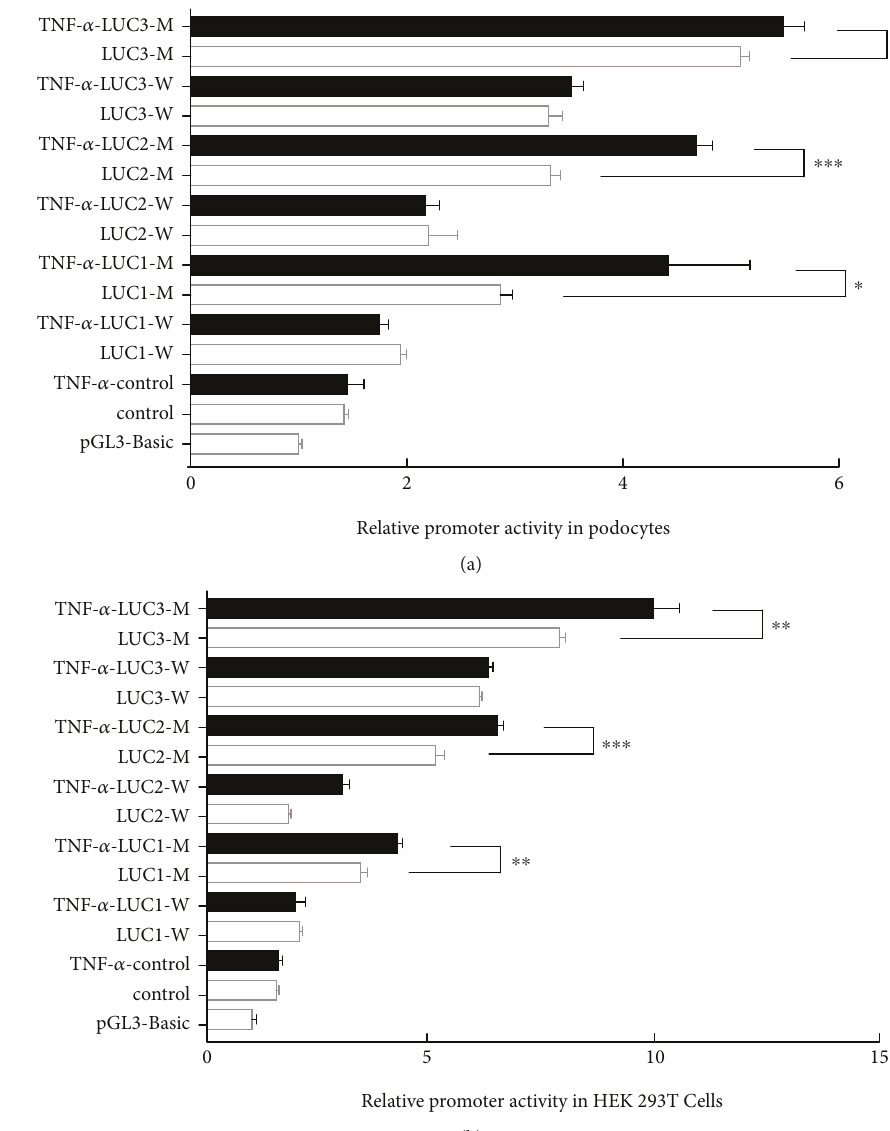
Figure 3: The TNF- α -mediated promoter activities are enhanced in podocytes and HEK 293T cells transfected with the reporter constructs containing the − 254G allele. (a) In the TNF- α -mediated condition, the − 254G allele (TNF- α -LUC1/2/3-M) signi fi cantly increased the luciferase activity of the TRPC6 gene in podocytes. (b) The results in HEK 293T cells were the same as that